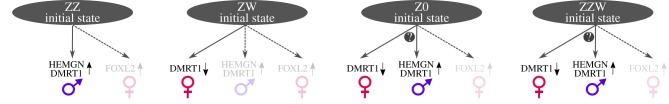
Illustration of the concurrent events leading to distinct sexual fates for different chromosomal constitutions of the gonad. Priority settings to settle these conflicting events are proposed for the ZZ and ZW gonads (table 1). (Online version in colour.)